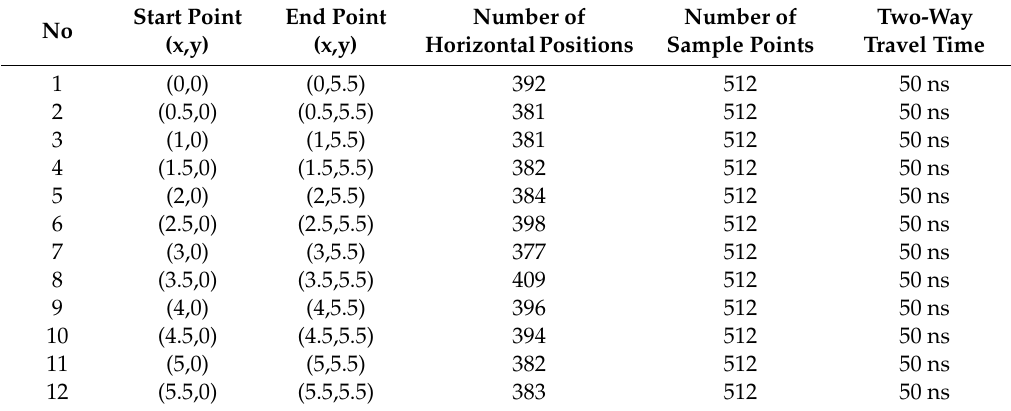
Table 2. Acquired experimental data.